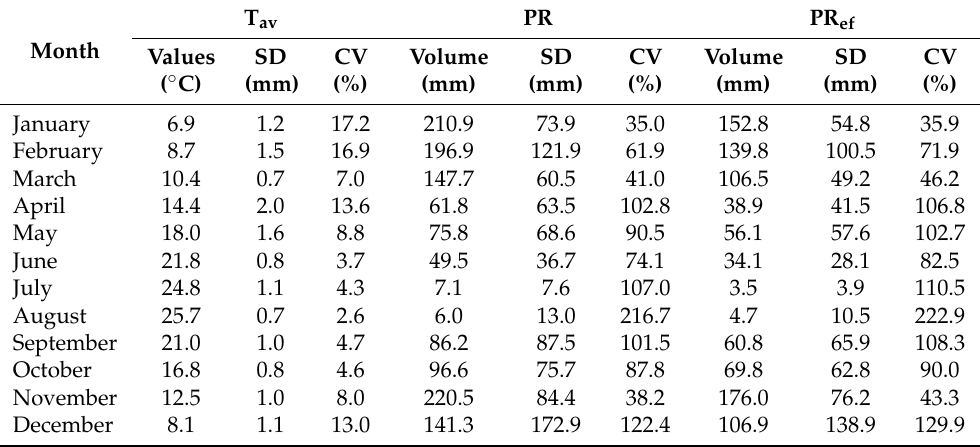
Table 2. Monthly T av , average monthly PR and PR ef (mm) for the study period